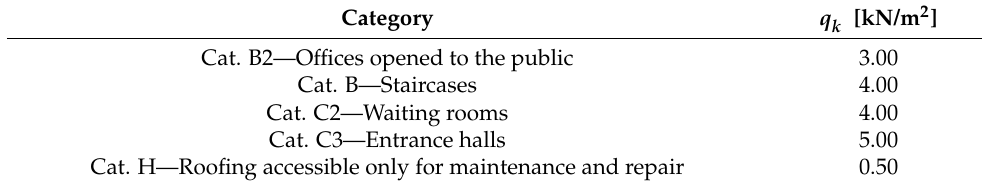
Table 5. Characteristic values of live